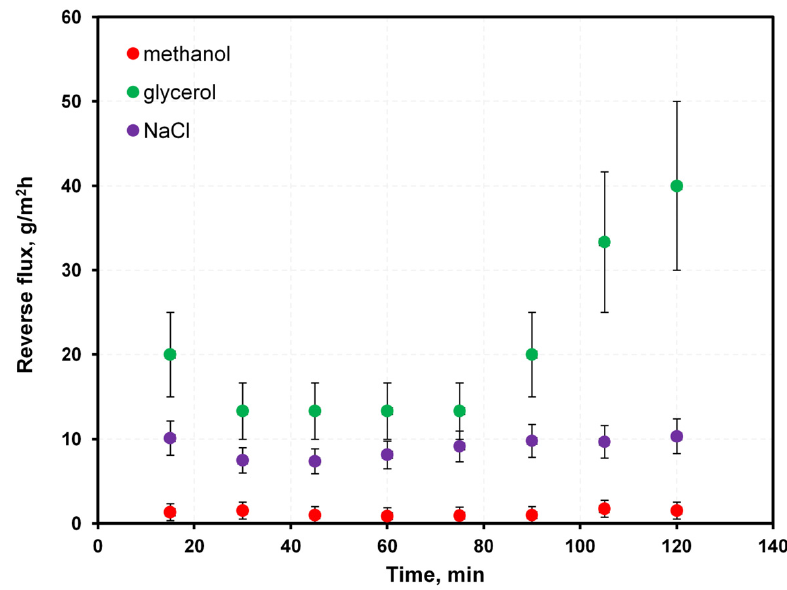
Figure 6. The measured reverse fluxes of impurities through FO Aquaporin membrane in a water–40% glycerol–3% salt–5% methanol system.